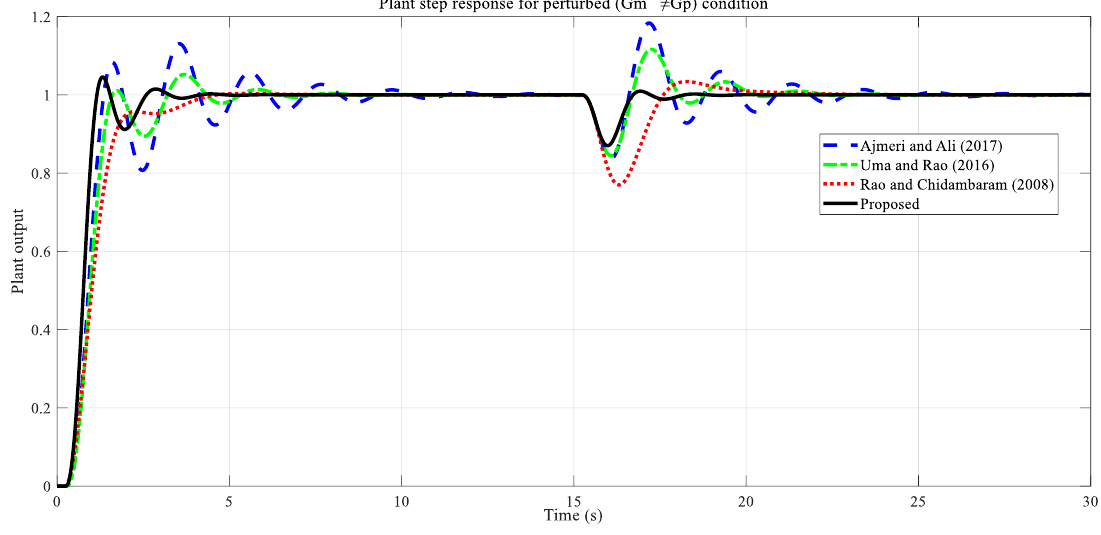
Figure 15. Performance comparison of the proposed method and the other methods, in terms of parameter changes, for Example 3 [15,16,18].